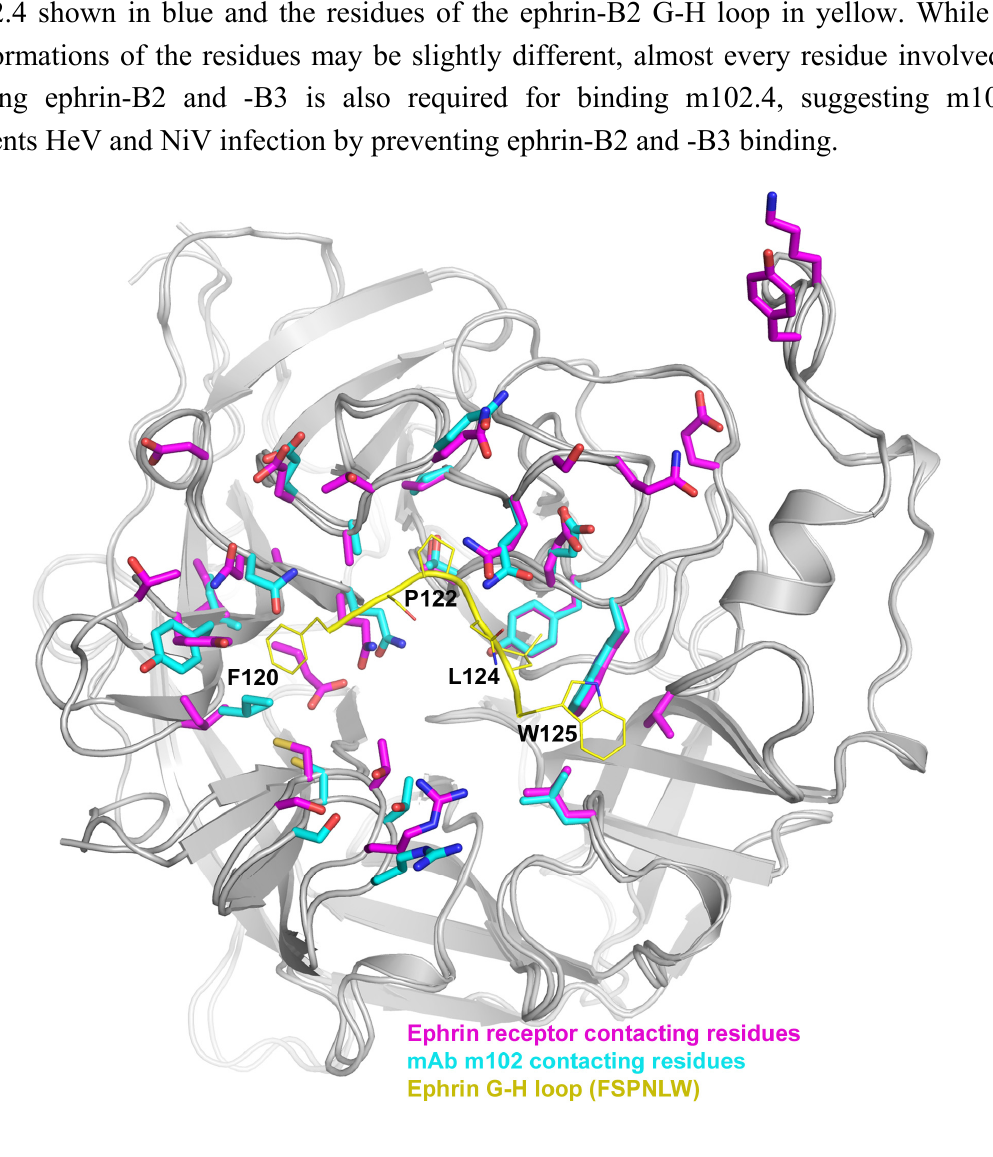
Figure 3. HeV-G residues that bind ephrin and monoclonal antibody